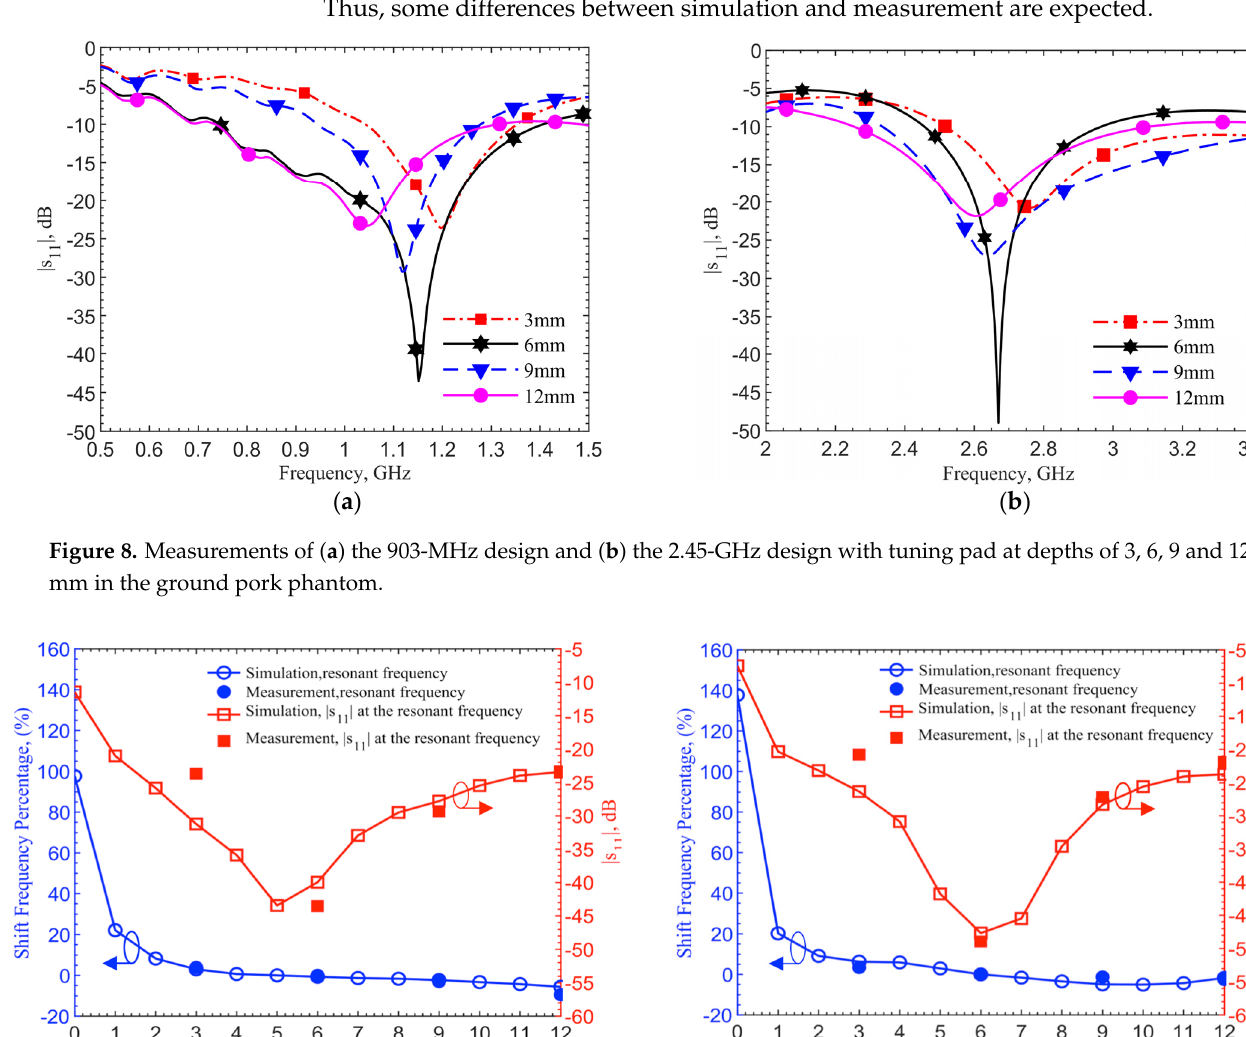
Figure 9. Frequency shift percentage (left y-axis) and s 11 magnitude (right y-axis) in the depth of 0 (cid:3398) 12 mm for the ( a ) 903-MHz and ( b ) 2.45-GHz designs with tuning pad. Measurements in discrete depths of 3, 6, 9 and 12 mm are compared with simulation results obtained at 1-mm steps.